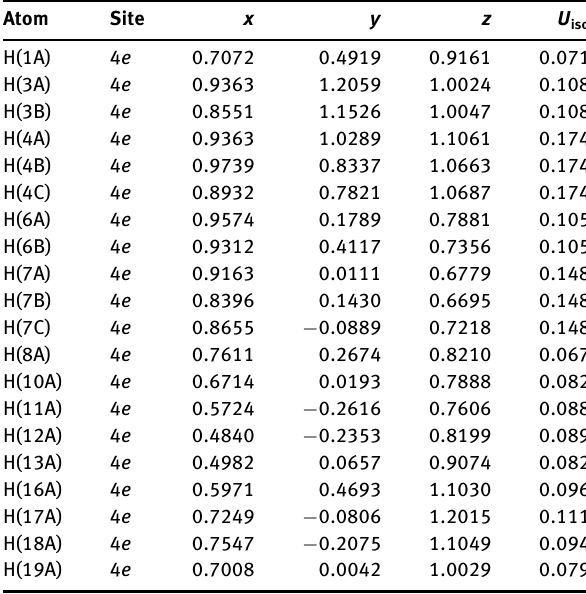
Table 2: Fractional atomic coordinates and isotropic or equivalent isotropic displacement parameters (Å 2